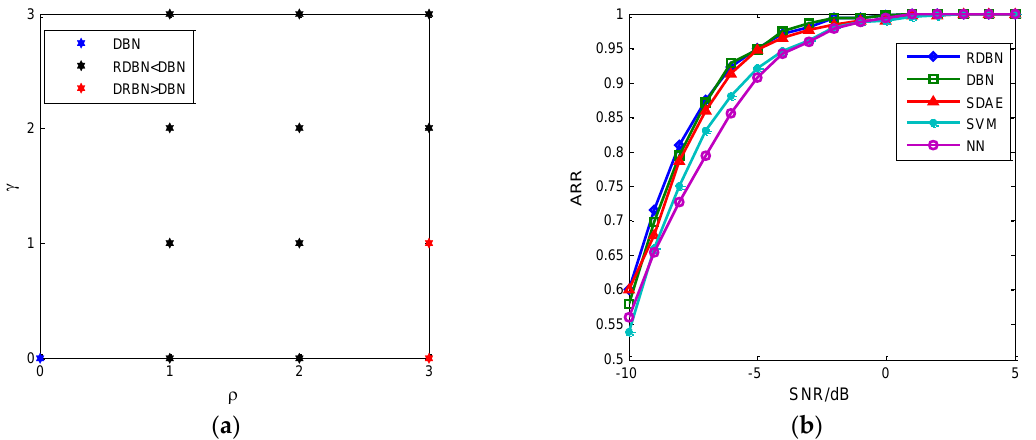
Figure 12. The comparison between DBN and RDBN. ( a ) The effect of tuning factor on SRR at − 5 dB; ( b ) Recognition result of different recognition networks .